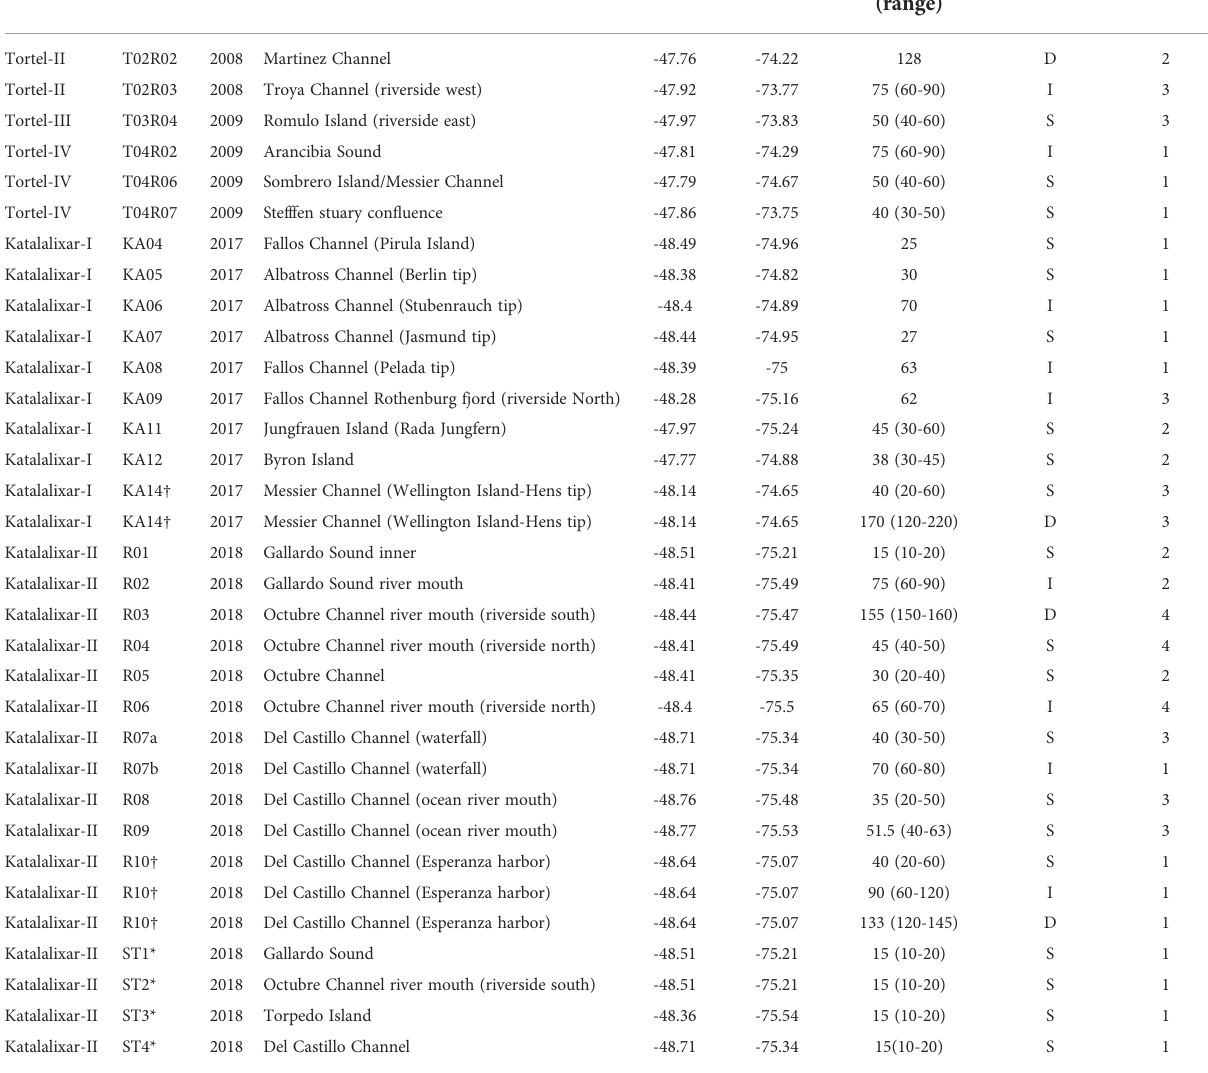
TABLE 1 Summary of expeditions; station list of sampling locations (latitude and longitude) during austral summer (2008, 2009, and 2018) and during austral winter (2009 and 2017). Expedition Station